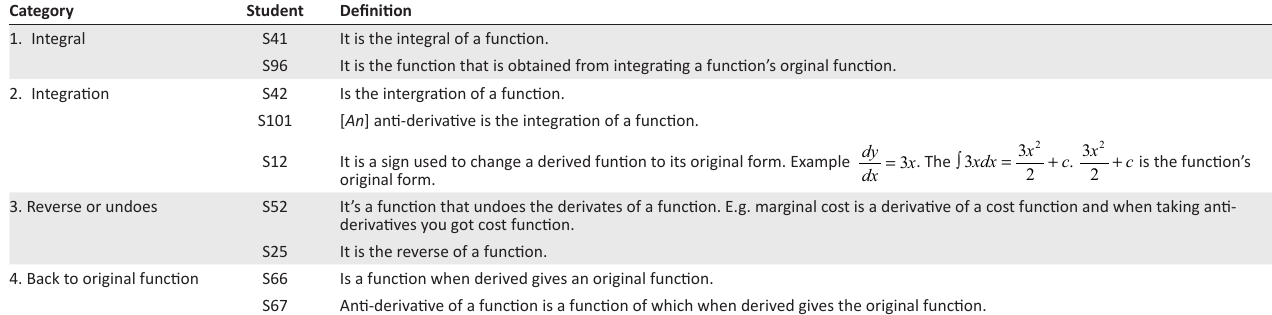
TABLE 2: Students’ definitions of